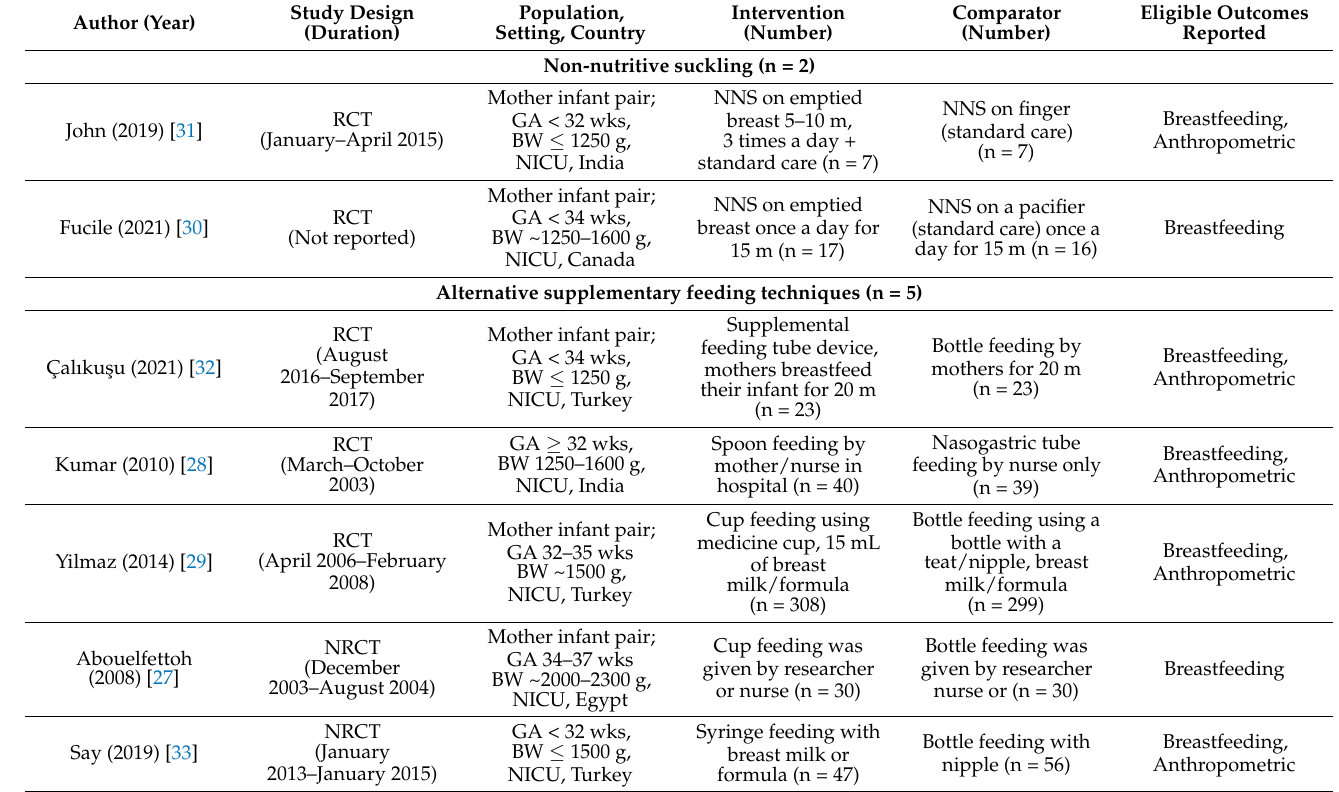
Table 1. Characteristics of included